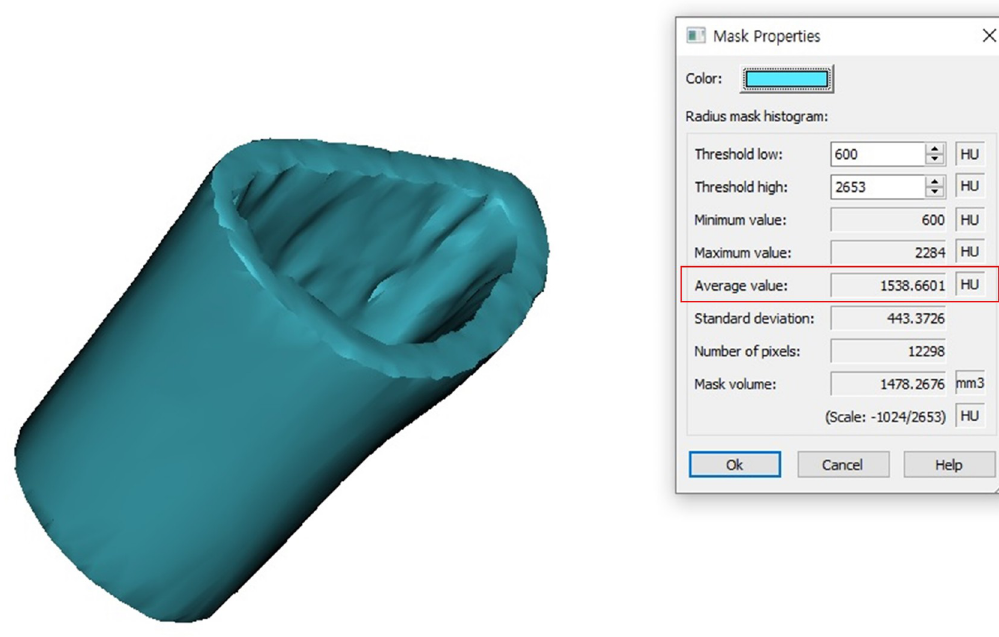
Fig 4. Average Hounsfield Unit (HU) calculation. Automatic calculation of the average HU (Cd of ROI) in the Mimics 1 software.